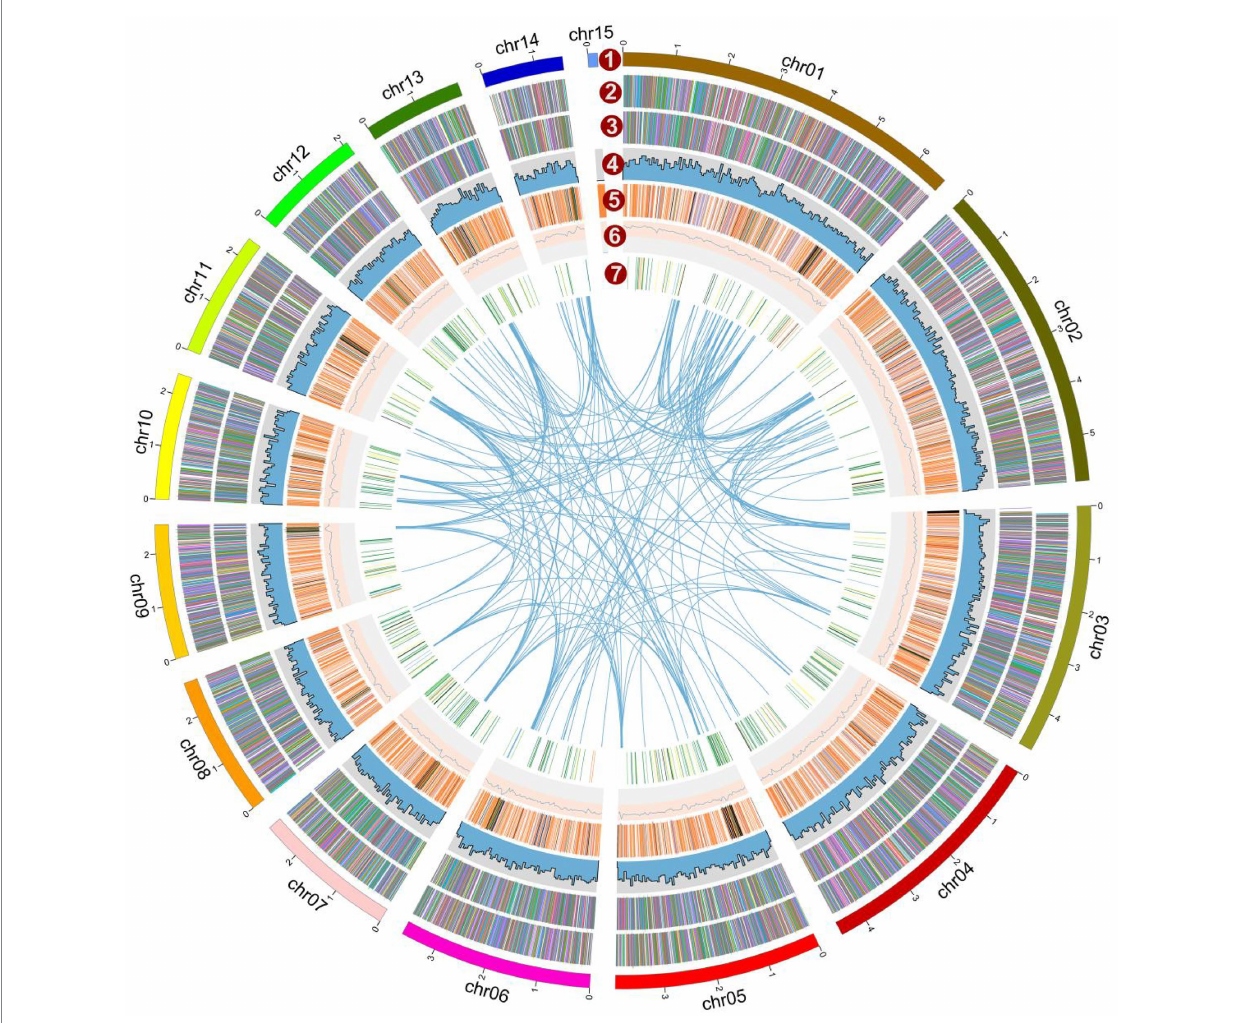
FIGURE 2 Overview of the Lyophyllum decastes genome assembly and gene prediction. The outermost layer 1 of colored blocks is a circular representation of the 15 contigs, with a scale mark labeling each 1 Mb. Layer 2 and 3, predicted genes in forward and reverse strand of genome; Layer 4, gene density; Layer 5, repeat sequences; Layer 6, GC content; Layer 7, CAZymes coding genes. Links within and between chromosomes represent collinear blocks generated from MCScanX. The window size is 50 kb. The plot was visualized using Circos software.